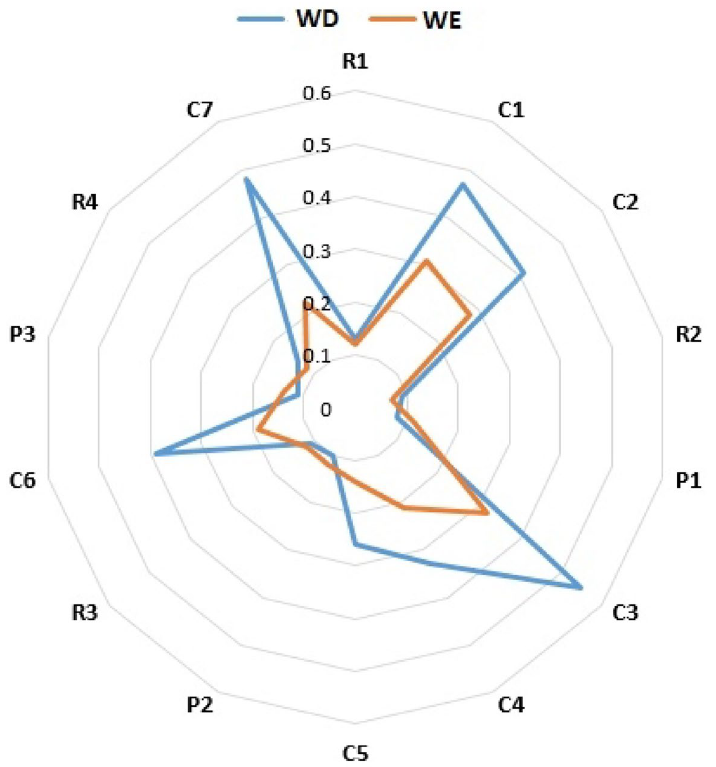
Figure 2. Daily variation of littered cigarette butt density in locations (WD = Working days, WE = Weekend).